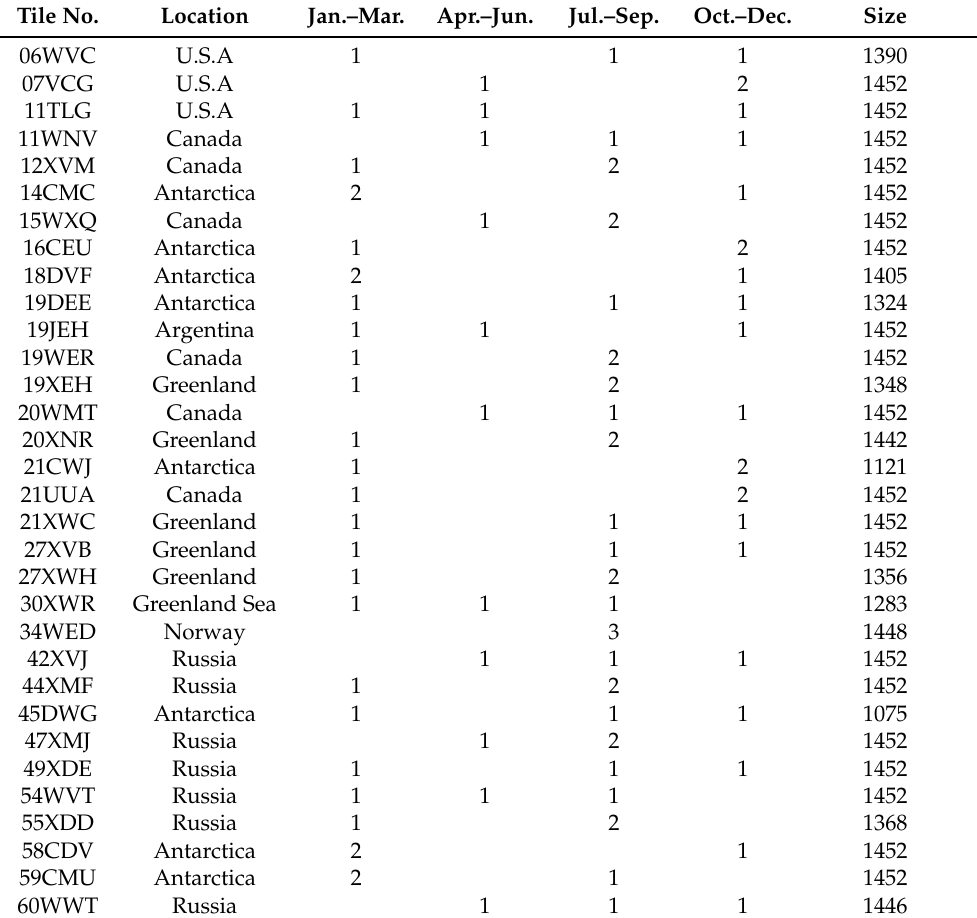
Table A1. Tile-wise quarterly distribution of scenes present in the training dataset. The size column